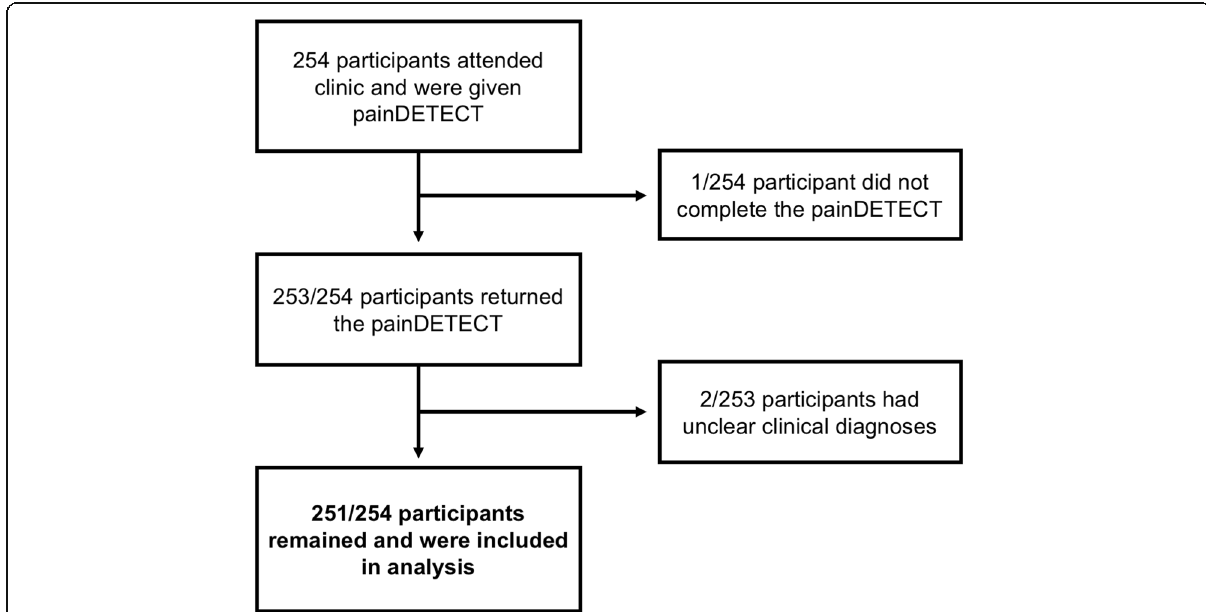
Fig. 1 Participant flow diagram. One patient who did not complete the questionnaire had difficulty reading the questionnaire. The two patients with unclear clinical diagnoses were categorised as having orofacial pain of mixed aetiology